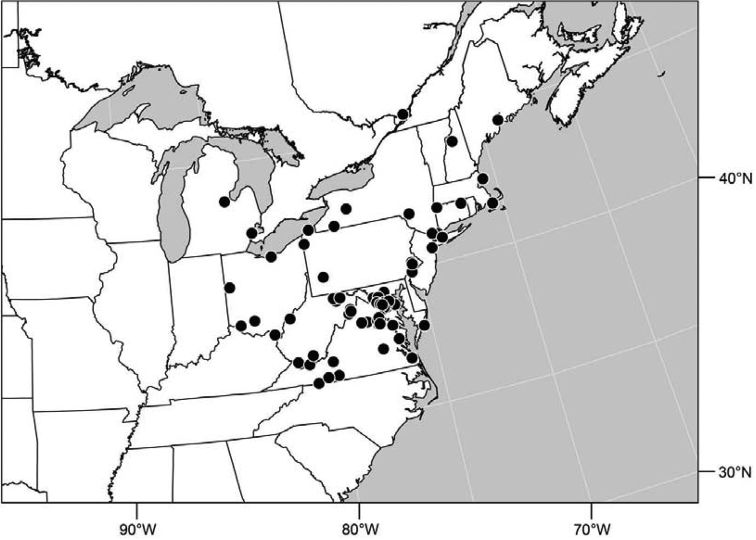
Distribution of Polytrichophora orbitalis (Loew).